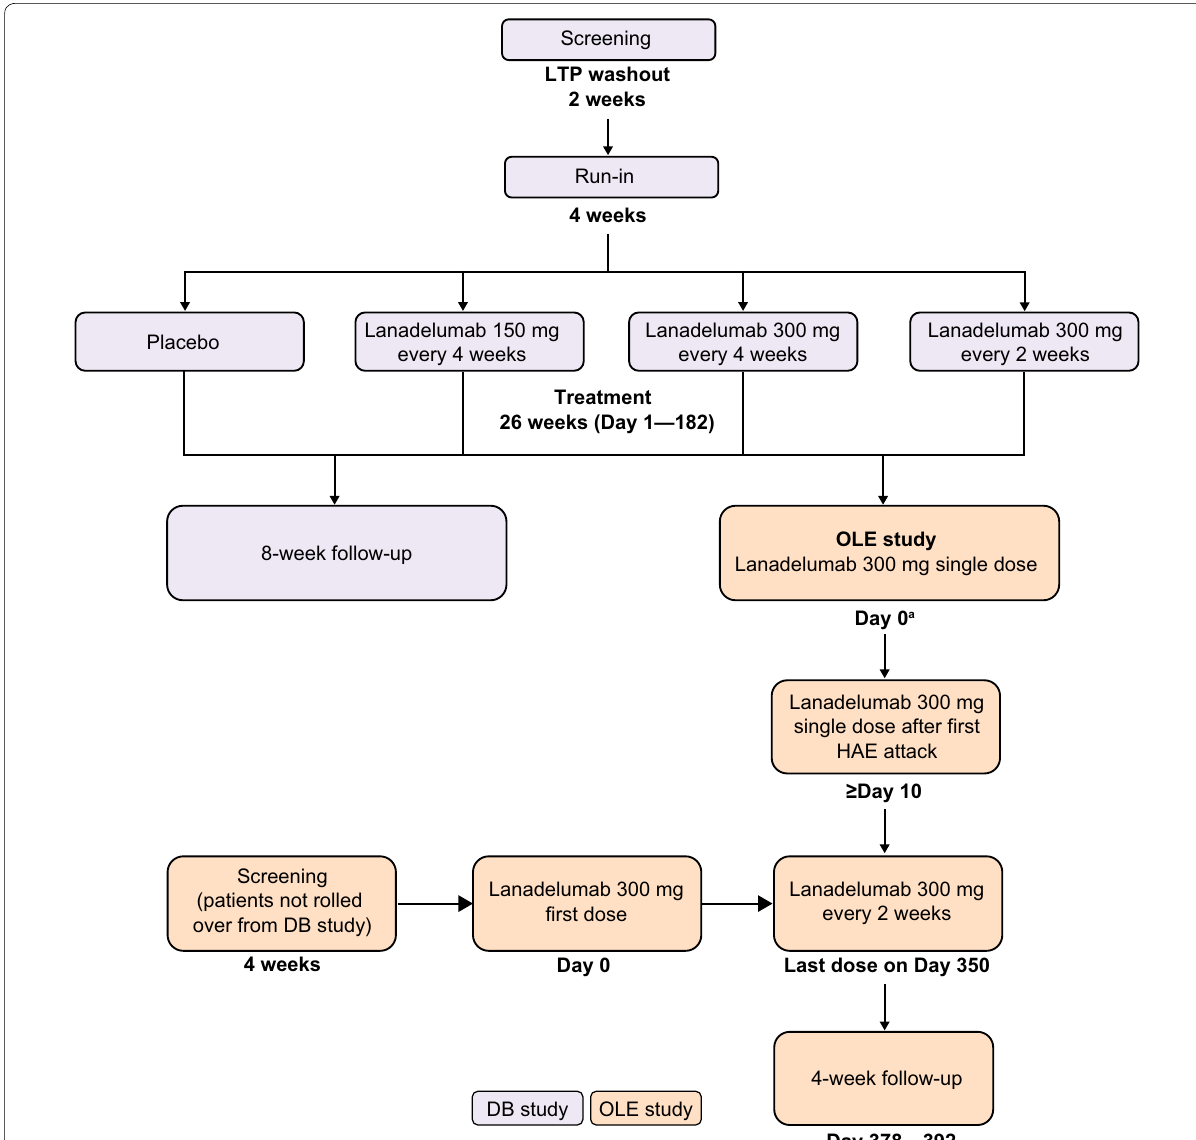
Fig. 1 Overview of study design. DB double-blind; HAE hereditary angioedema, LTP long-term prophylaxis; OLE open-label extension. a For rollover patients, Day 0 of the open-label extension study coincides with Day 182 of the double-blind